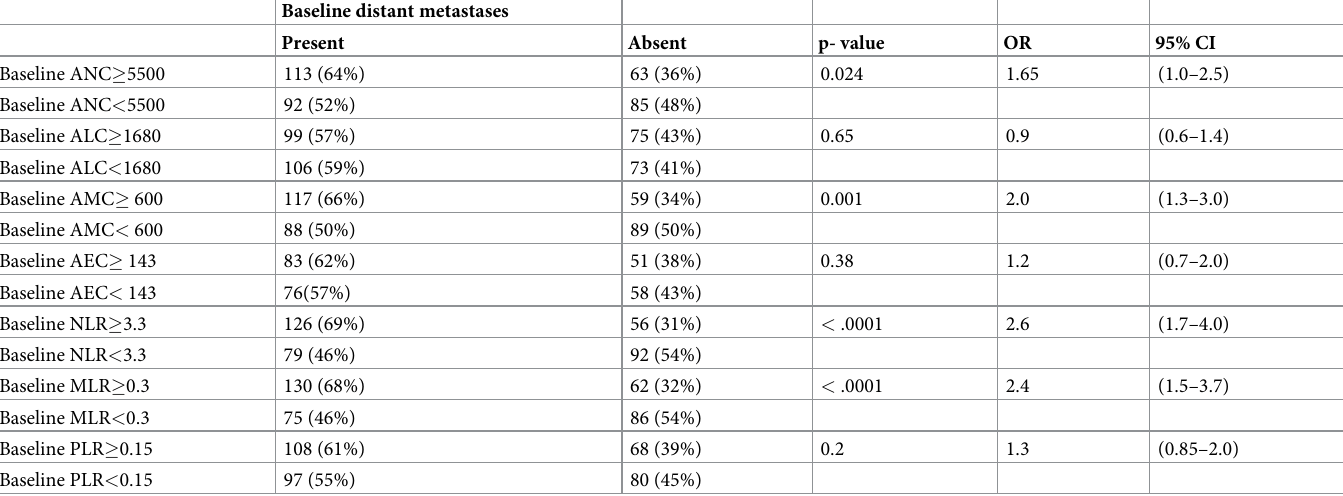
Table 2. The association between hematologic indices with the presence of baseline distant metastases. Baseline distant metastases